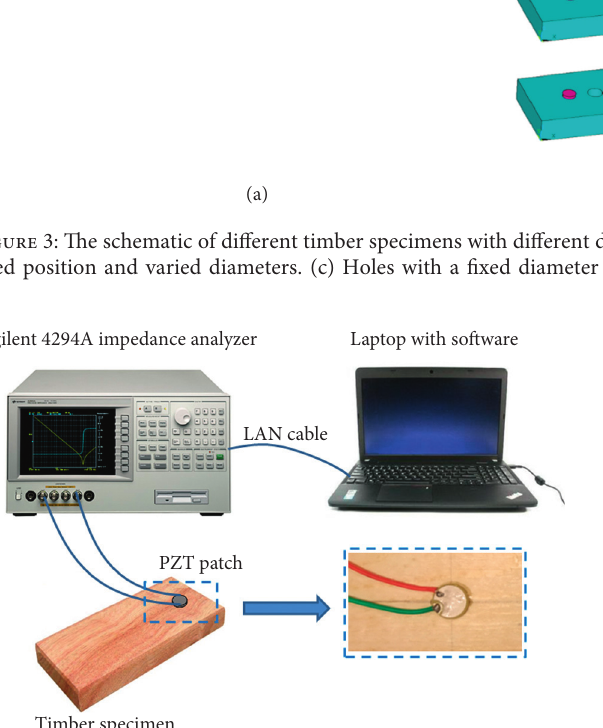
Figure 4: The schematic of damage detection of timber specimen based on EMI technique.